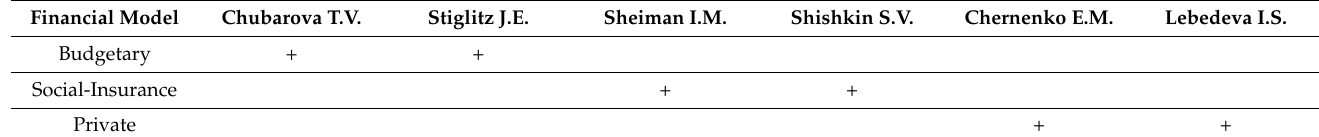
Table 2. Russian authors’ positions on the financial models.